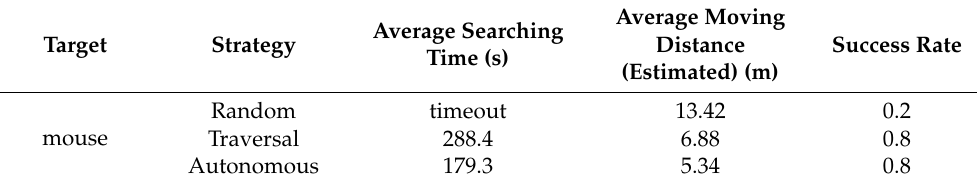
Table 3. The performance of different strategies in real scenario.